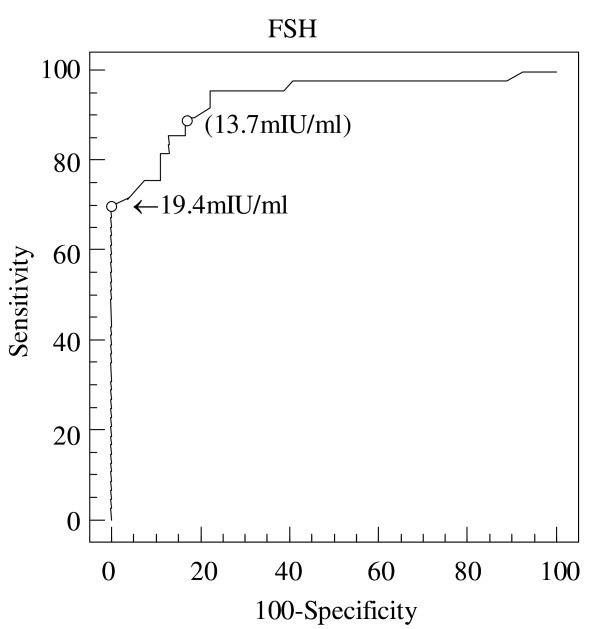
Depiction of ROC curves of serum FSH can discriminate between successful or failed sperm retrieval. Depiction of receiver operating characteristic (ROC) curves of serum follicle-stimulating hormone (FSH) can discriminate between successful or failed sperm retrieval. The area under the ROC curves was 0.939 ± 0.02 (with a 95% confidence interval for the area being between 0.891 and 0.986). A FSH cut-off point of 13.7 mIU/mL discriminated between groups A and B with a sensitivity of 85.7% and a specificity of 87.0%. When the cut-off point was increased to 19.4 mIU/mL, the sensitivity of FSH level was 70% and the specificity was 100%. Arrows indicate the cut-off point for serum FSH 19.4 mIU/mL.